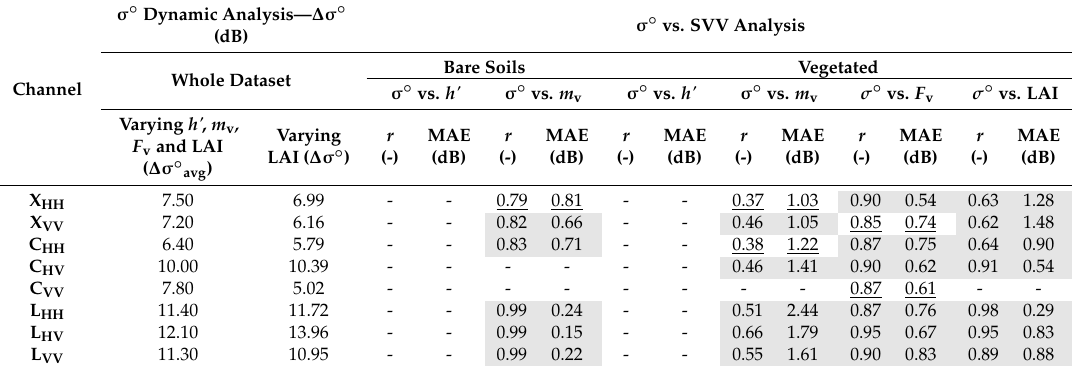
Table 13. Best results achieved through the inter-channel correlation analysis. Additionally, to the key legend of Table 12, improvements, with respect to the single regression approach, are highlighted in blue; bolded blue values refer to improvements achieved through the multi-frequency approach.